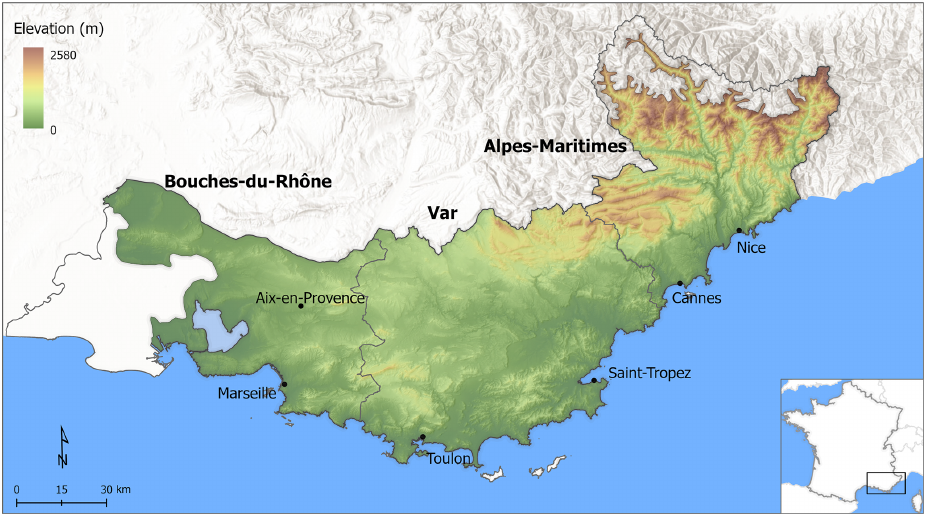
Figure 1. Map of southeastern France showing the study area and the administrative division limits overlain on a 5m digital elevation model.